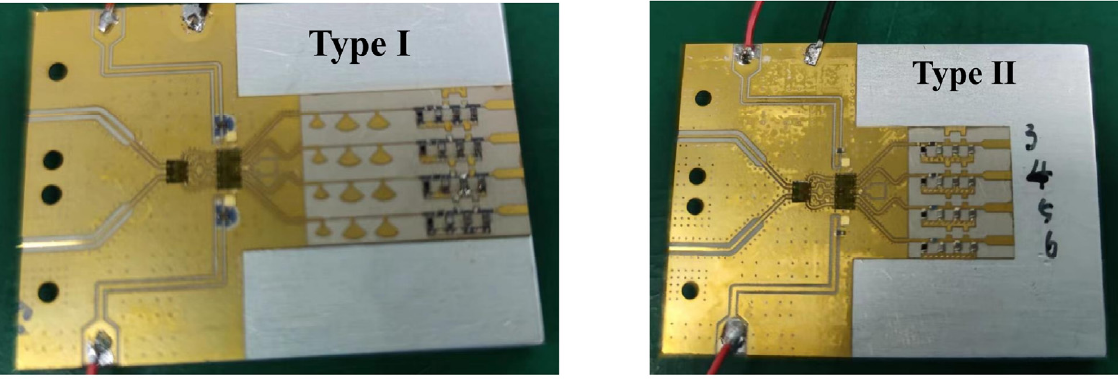
Figure 11. The fabricated analog correlators.